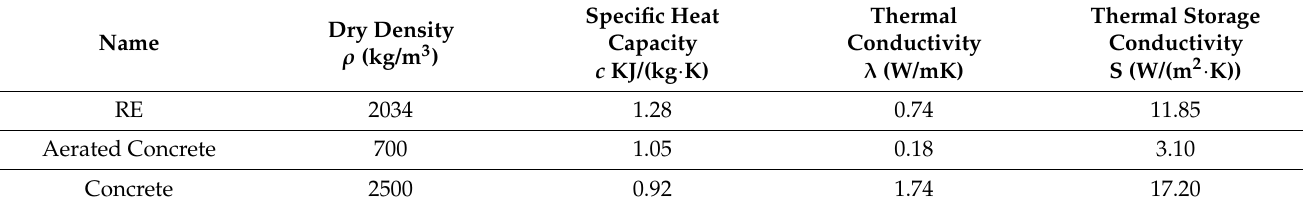
Table 2. Physical Parameters of the Test Blocks.